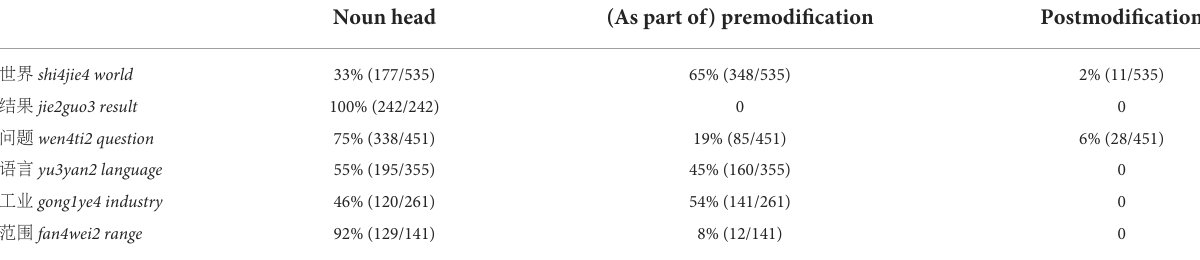
TABLE 13 A comparison of the grammatical distribution of 世 界 shi4jie4 in the nominal group with that of the other five nouns in the LCMC. Noun head (As part of) premodification